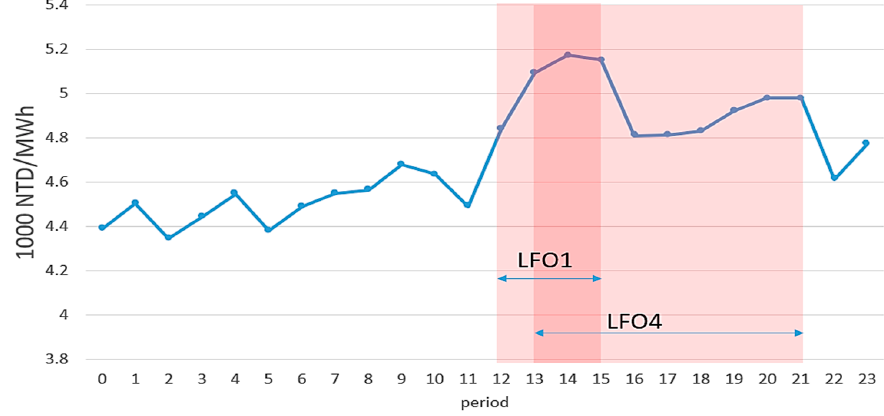
Figure 11. The hourly average power generation cost for the day with maximum load (case 2).